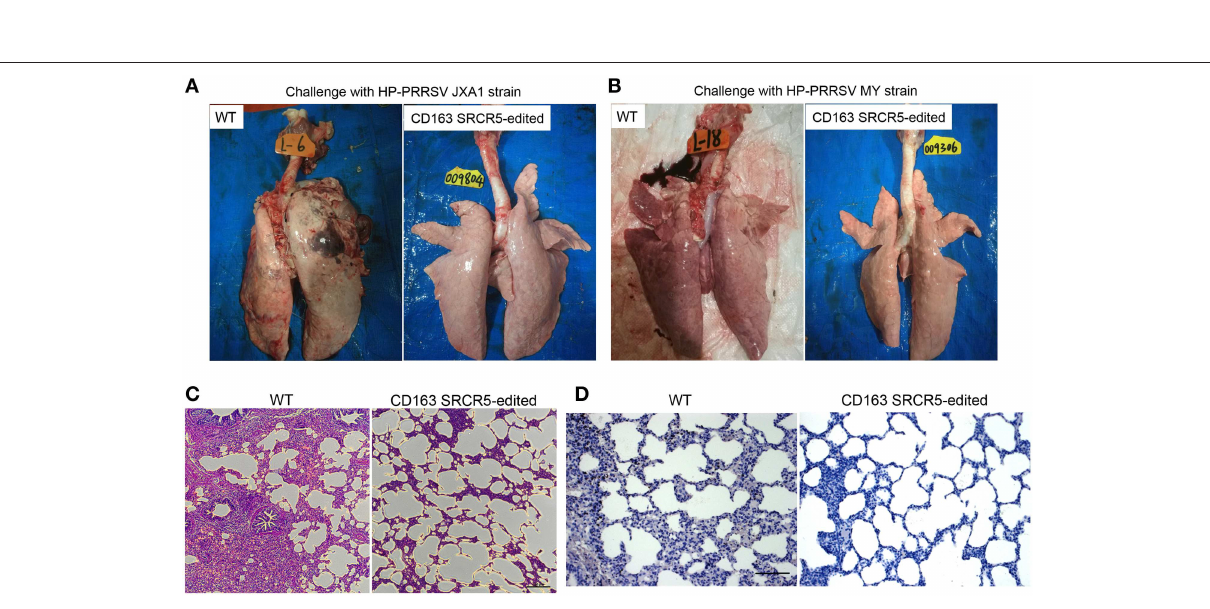
Frontiers in Immunology |